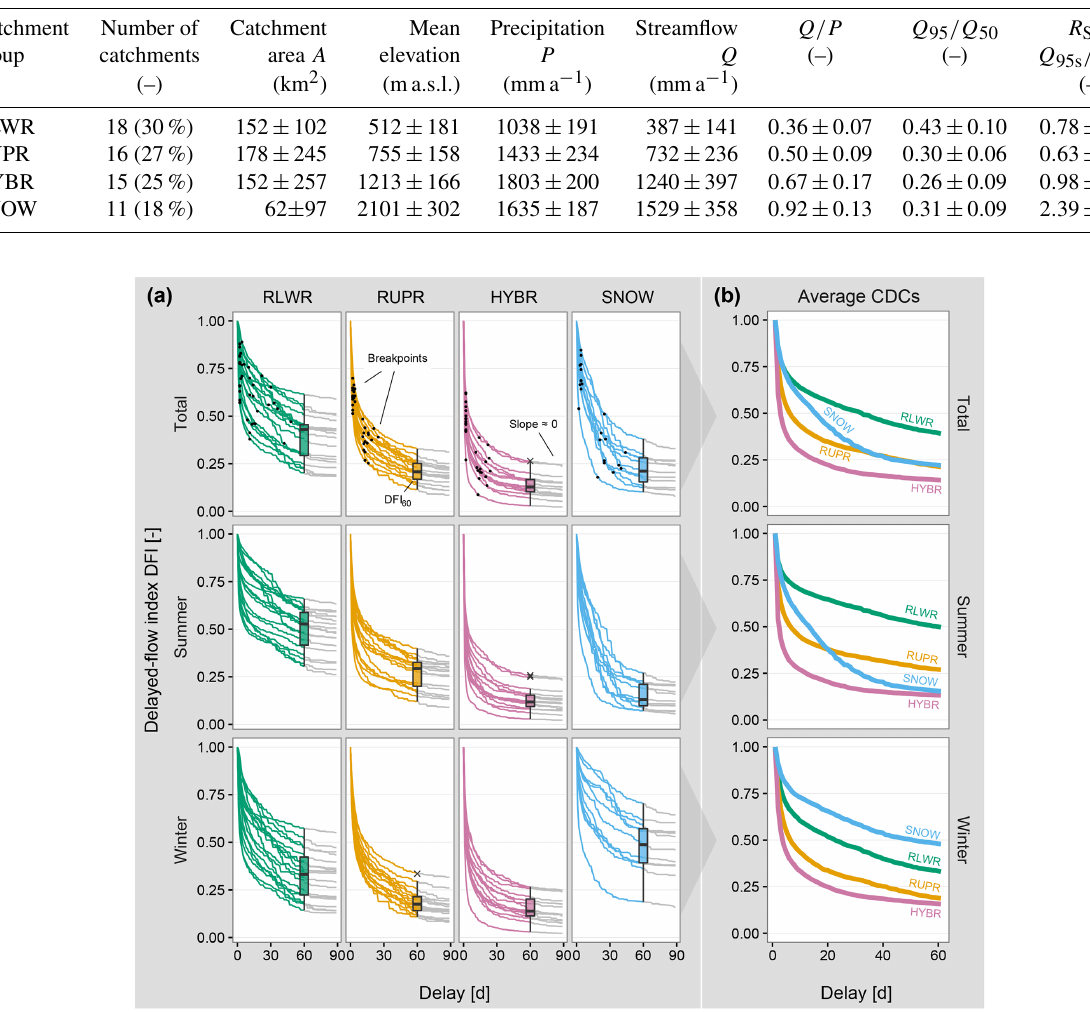
Figure 5. Characteristic delay curves (CDCs) (a) for all catchments and (b) as the average for each catchment groups. CDCs are shown for the whole year and summer (May–October) and winter (November–April) separately. Black dots are estimated breakpoints. Boxplots show the distribution of DFI 60 values. The grey lines (delay > 60d) have very small or zero